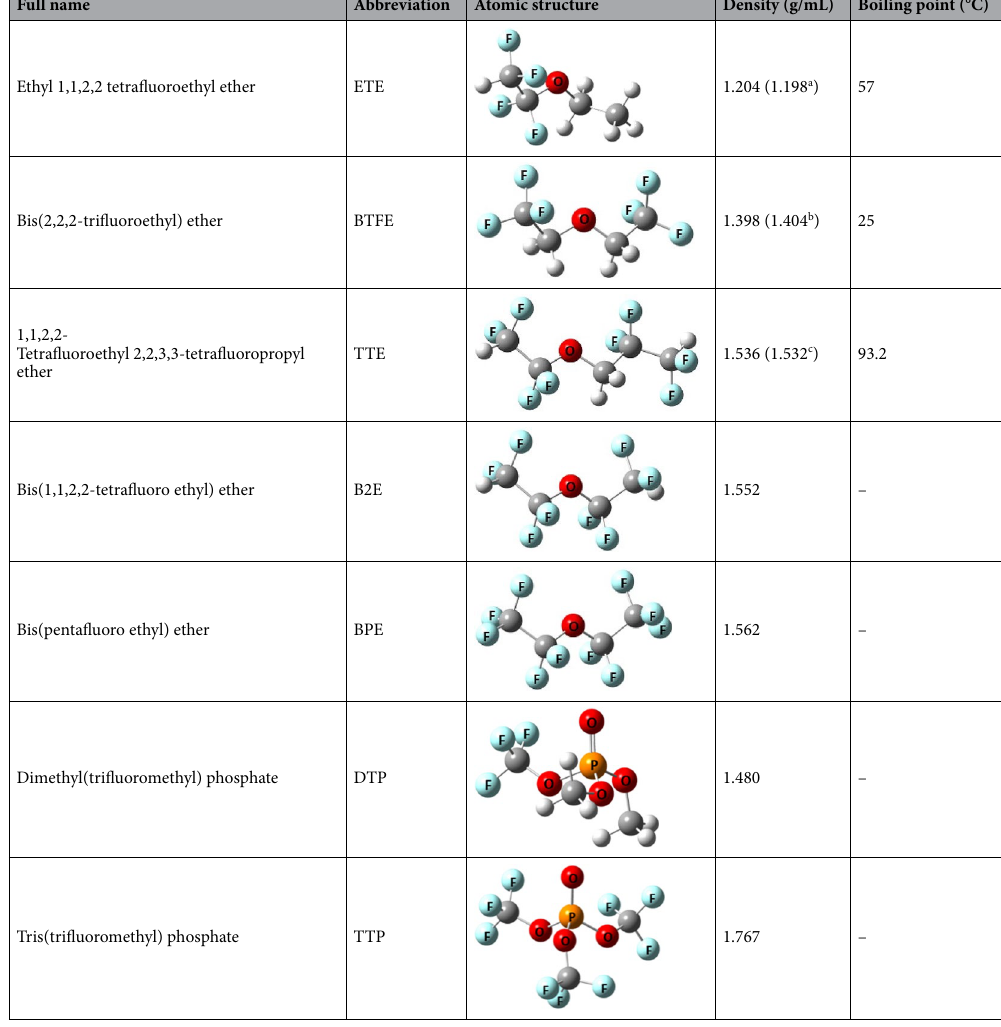
Table 1. The considered systems used for this study. a Ref. 19 . b Ref. 20 . c Ref. 21